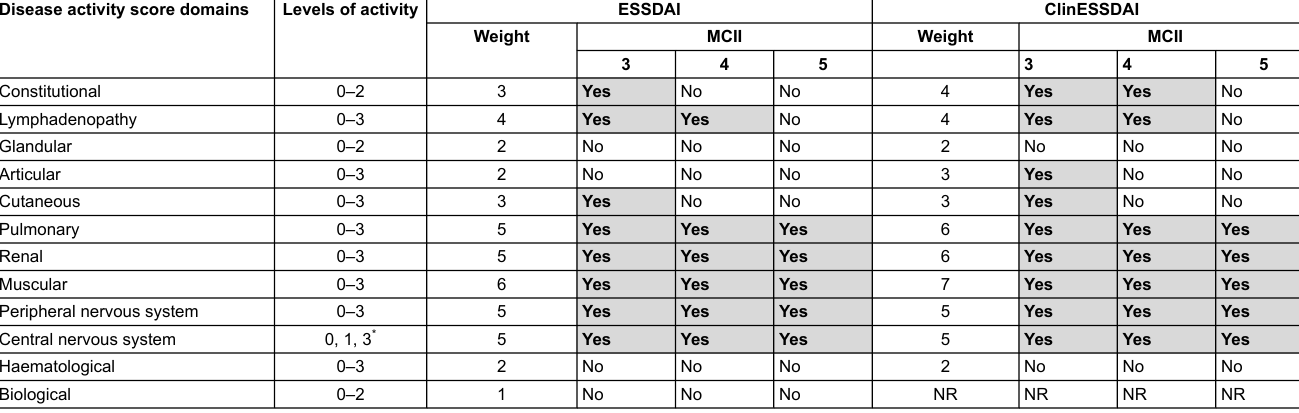
Table 1: Levels of activity and respective weights of indexes domains and theoretical illustration of disease activity indexes ability to improve according to selected MCII values. Does a one grade improvement in one domain permit reaching the MCII when using ESSDAI or ClinESSDAI for selected MCII values?